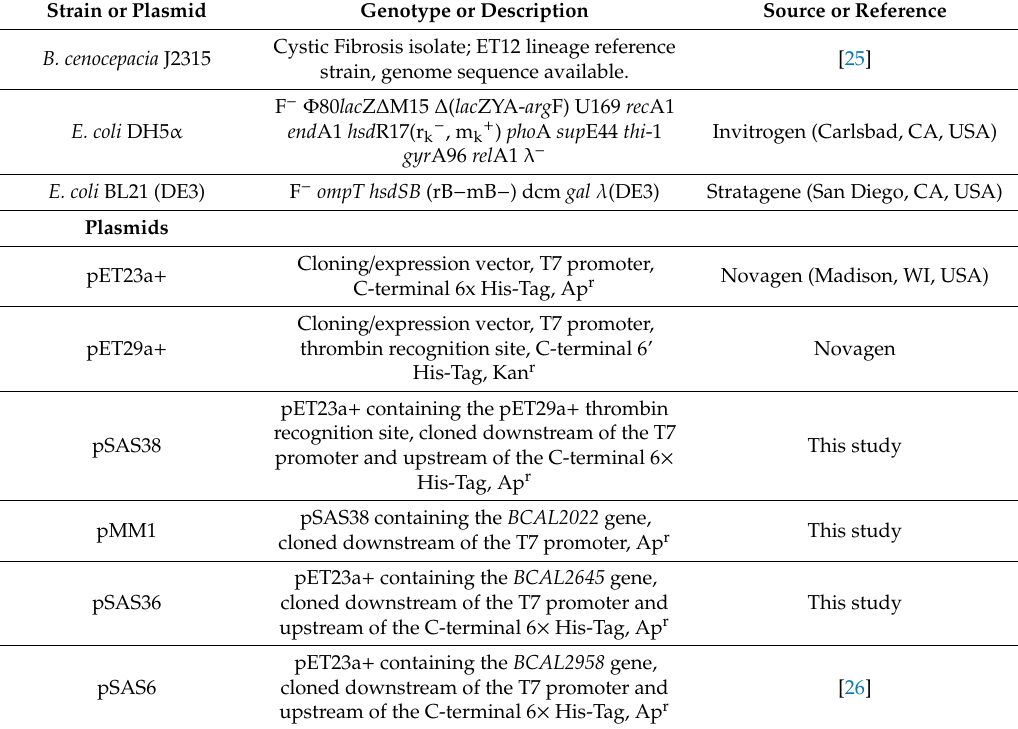
Table 1. Bacterial strains and plasmids used in this work. Ap R , resistant to ampicillin; Kan R , resistant to